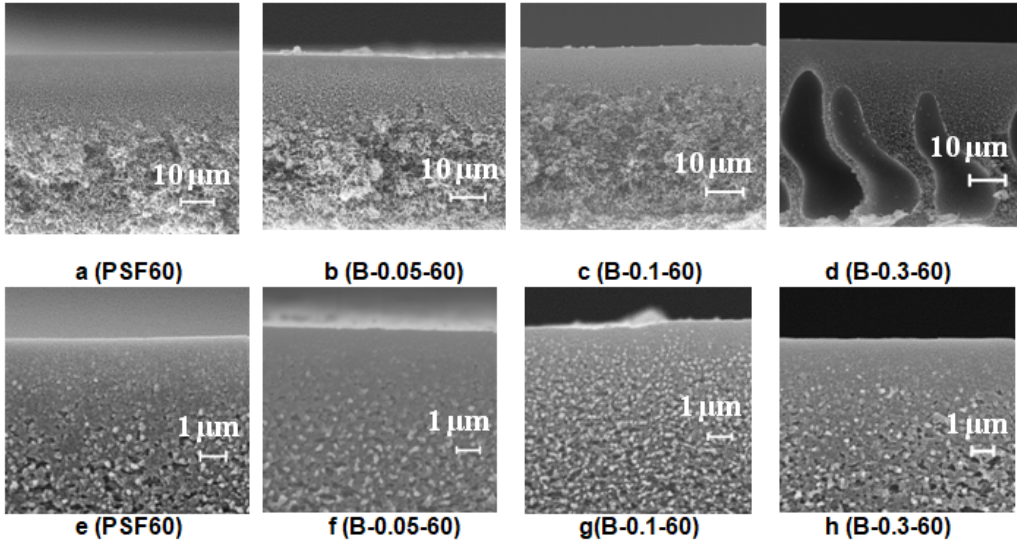
Figure 8. SEM images of the PSF membrane cross-section ( a – d ) and selective layer ( e – h ) prepared using a rough glass plate, Praestol 859 concentration in the coagulation bath ( T = 60 °C), wt.%: (a,e) 0; ( b , f ) 0.05; ( d , h ) (b,f) 0.05; (c,f) 0.3.